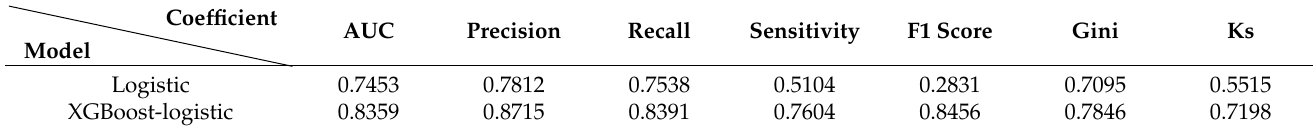
Table 6. Model evaluation analysis.